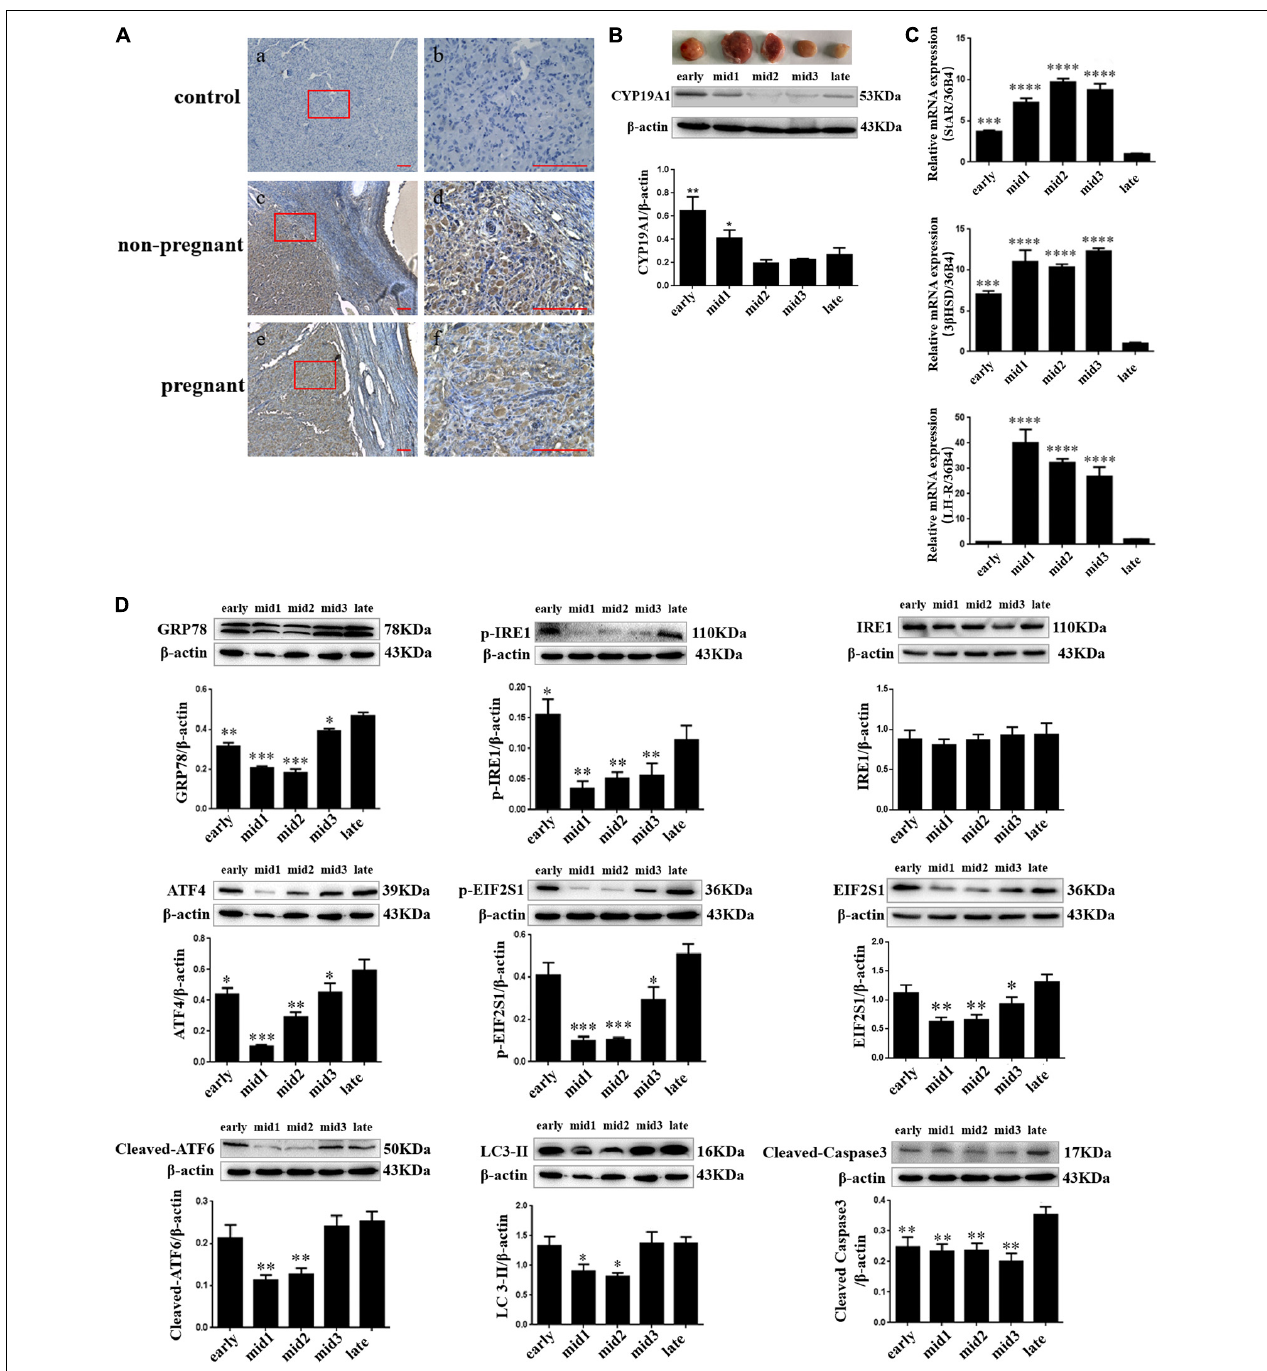
FIGURE 1 | ER stress, autophagy, and apoptosis-related proteins’ expression changes in different stages of the luteal phase of the goat corpus luteum. (A) The detection of ER stress molecule Grp78 in goat ovaries by IHC. (a,b) Negative control; (c,d) Non-pregnant goat ovary; (e,f) Pregnant goat ovary. Scale bar: a, c, and e: 10 mm; b, d, and f: 100 mm. (B) The detection of CYP19A1 protein expression in different corpus luteum to demonstrate the stages in the luteal phase of different corpus luteum. (C) The detection of STAR, 3 β HSD , and LH-R mRNA expression in different corpus luteum to demonstrate the stages in the luteal phase of different corpus luteum. (D) The detection of ER stress, autophagy, and apoptosis-related protein expression in different stages of the luteal phase of the goat corpus luteum is performed by western blot analysis. Data in the bar graph represent the means ± standard error of the mean (SEM) of three independent experiments ( N = 3). Means are compared with one-way ANOVA combined with Tukey’s post hoc tests. ∗ p < 0.05, ∗∗ p < 0.01, ∗∗∗ p < 0.001, ∗∗∗∗ p < 0.0001 compared to late.